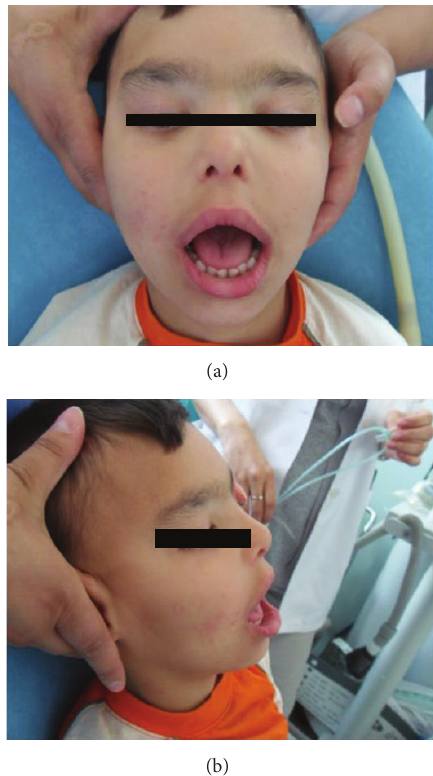
Figure 1: Orofacial clinical manifestations of a 6-year-old boy with PKS.